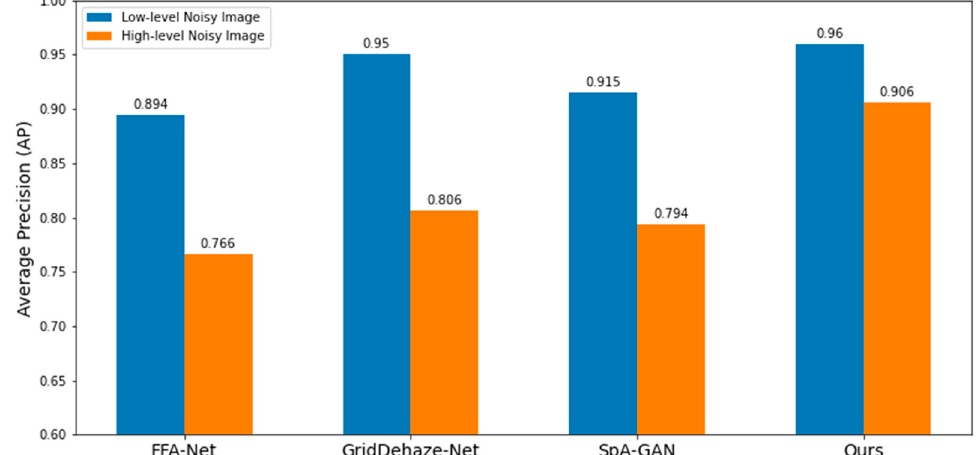
Sensors 2022 , 22 , x FOR PEER REVIEW